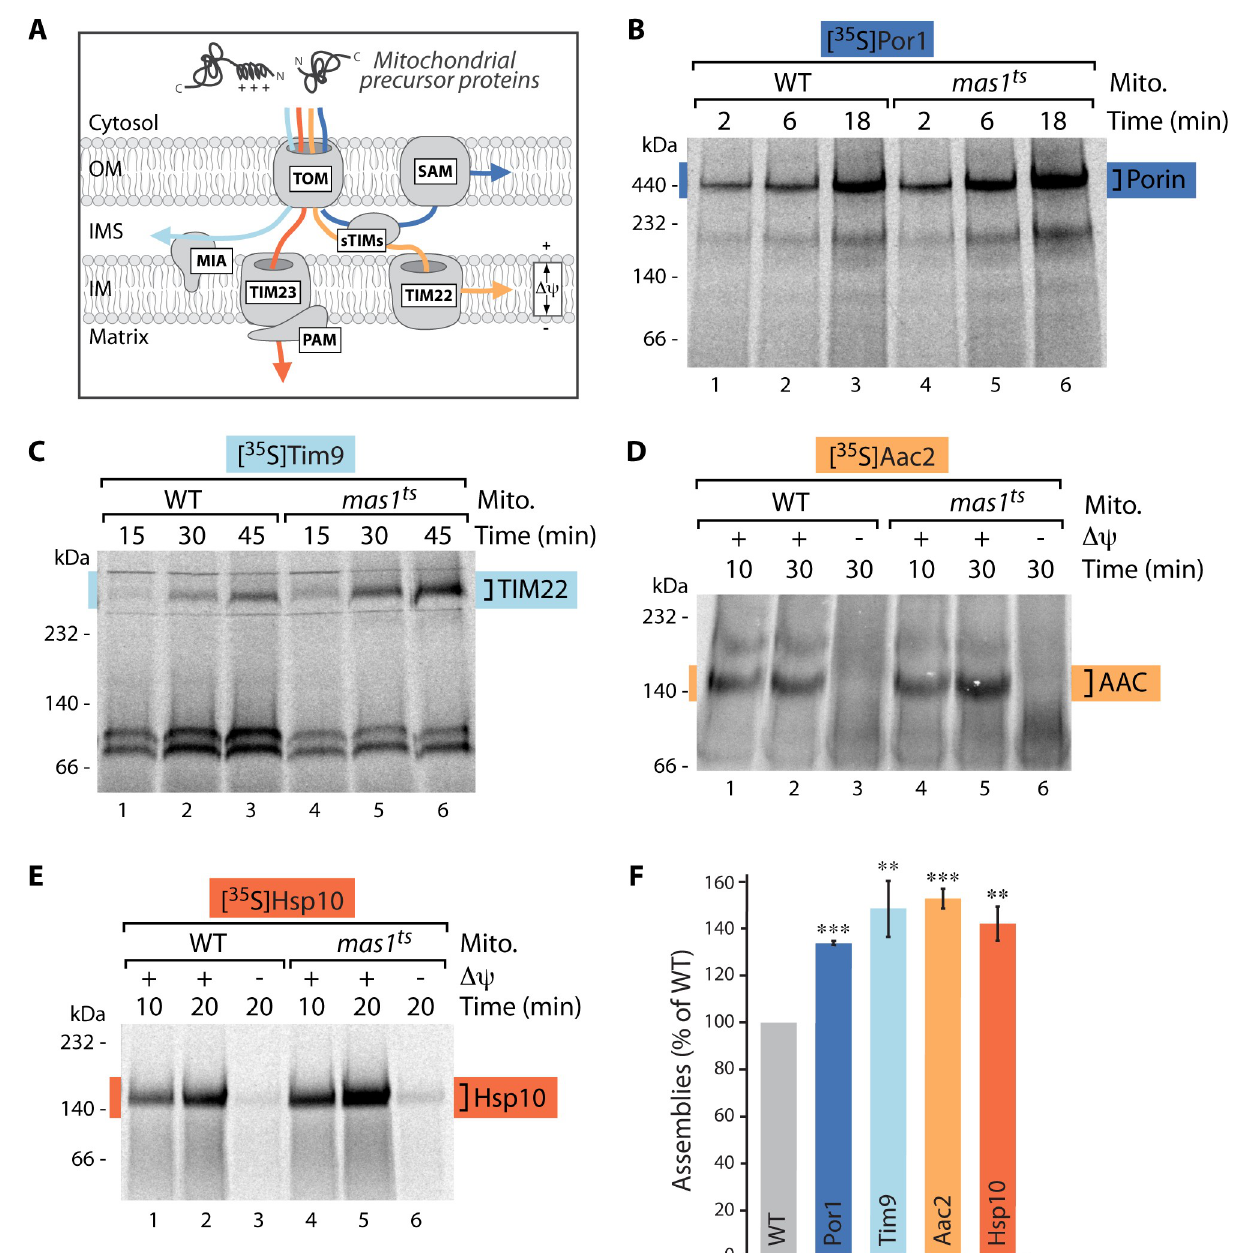
Fig 1. Protein import into all mitochondrial subcompartments is stimulated upon mtUPR. (A) Schematic of the main protein import pathways into mitochondria. Protein translocation into the matrix and inner membrane depends on the membrane potential ( Δ ψ ) as driving force, protein import into the outer membrane or intermembrane space is membrane potential-independent. TOM, translocase of the outer membrane; SAM, sorting and assembly machinery; sTIMs, small TIMs; MIA, mitochondrial intermembrane space assembly; TIM23 and TIM22, translocases of the inner membrane; PAM, presequence translocase associated motor; OM, outer mitochondrial membrane; IMS, intermembrane space; IM, inner mitochondrial membrane. (B)-(E) Import kinetics of indicated radiolabeled precursor proteins into mitochondria isolated from wild-type (WT) or mas1 ts cells after induction of mtUPR for 10 hours. Where indicated (in case of matrix- and inner membrane-targeted substrates), the membrane potential ( Δ ψ ) was dissipated prior to the import reaction. Samples were solubilized in the mild detergent digitonin and analyzed by BN-PAGE and autoradiography. In Fig 1C the soluble Tim9/Tim10 complex is formed at appr. 100 kDa. (F) Quantification of longest import time-point displayed in (B)-(E) normalized to WT value. n = 3, data represent means ± SEM. Student’s t-test was used for pairwise comparison. �� p < 0.01; ��� p < 0.001.